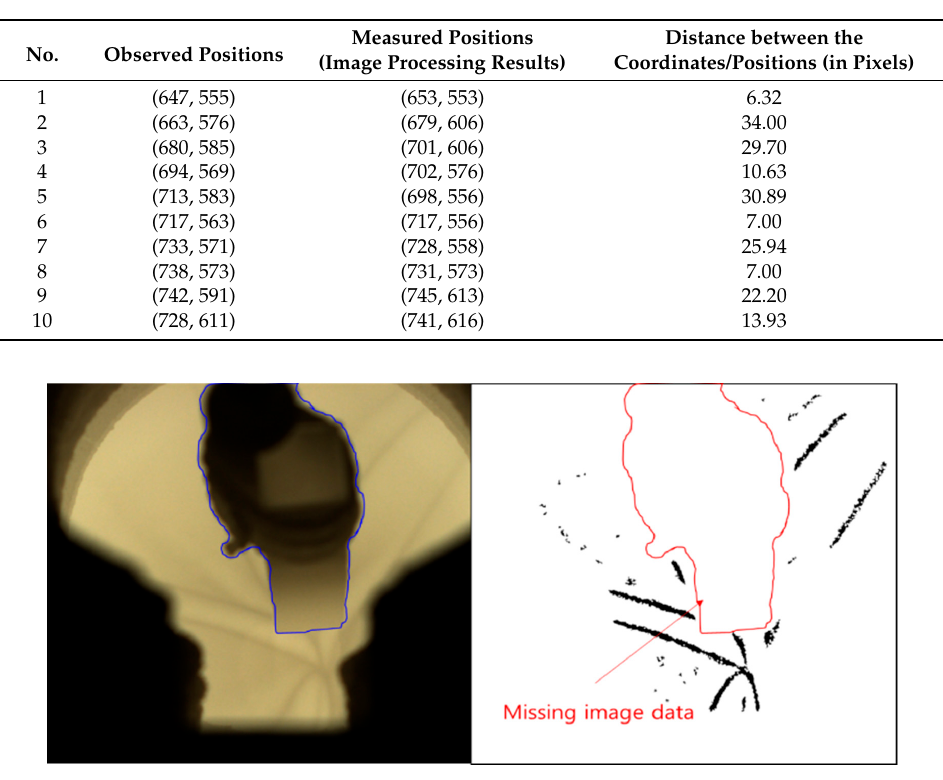
Figure 14. Loss of stream-line data caused by the outline of the rod and seed.